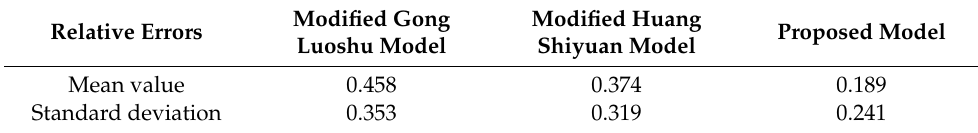
Figure 2. Comparison of relative errors between modified existing models and proposed model. Table 3. Comparison of Relative Errors of Three